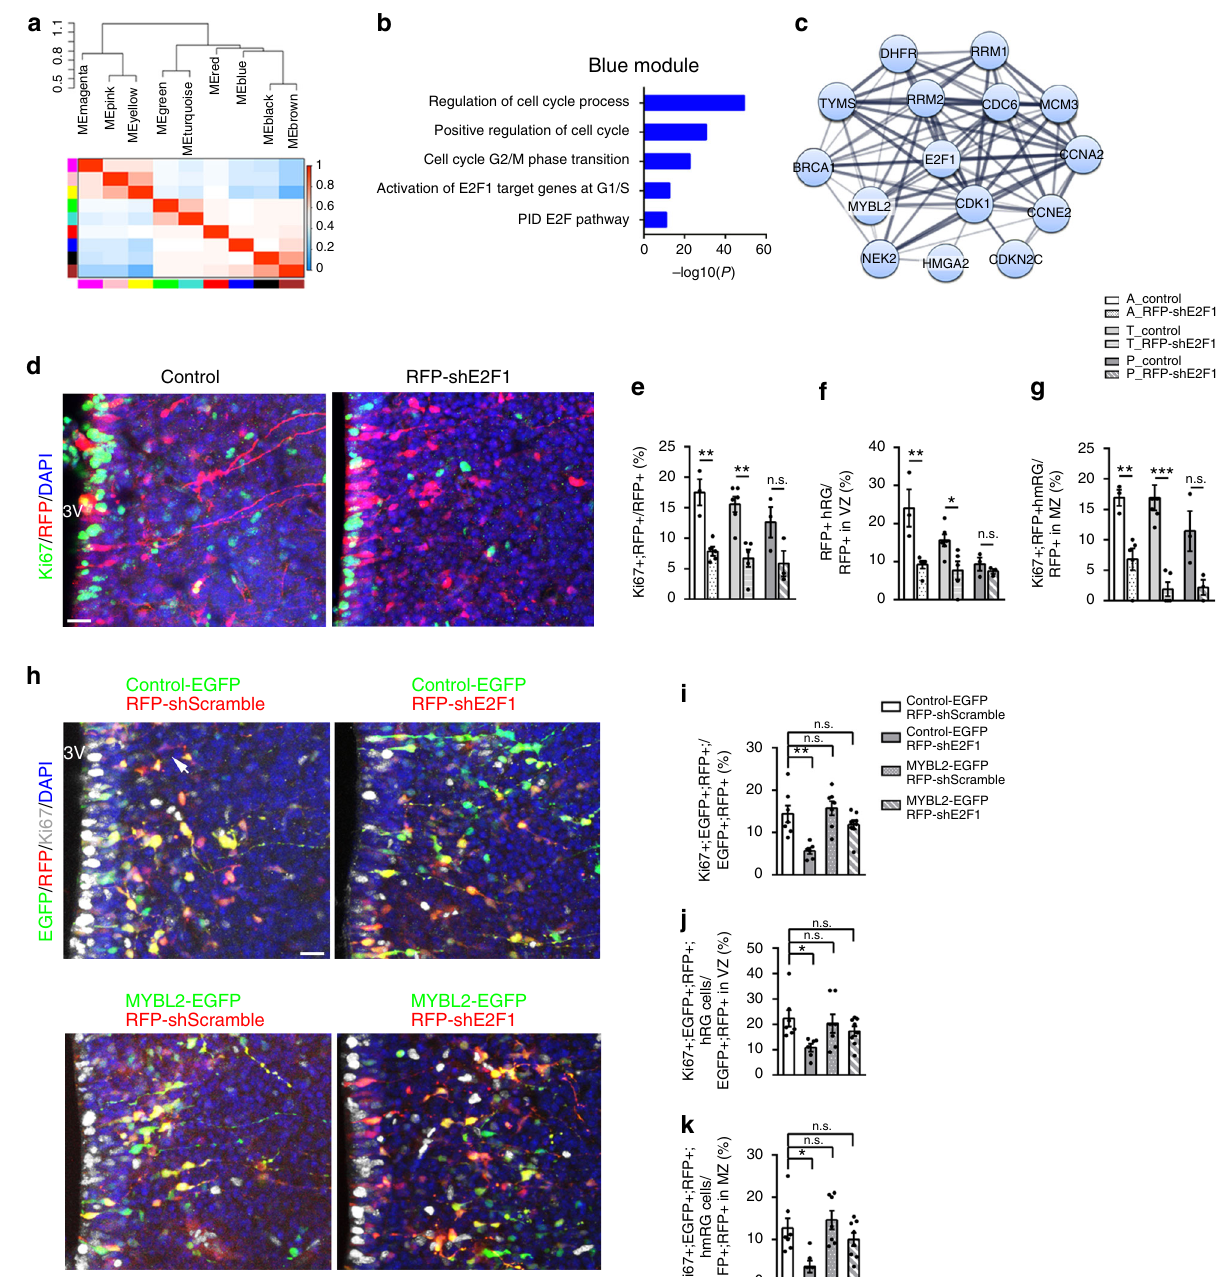
Fig. 5 Molecular signature of neural progenitor cells in the developing hypothalamus. a Eigen gene heatmap showing the relationships among the modules across hypothalamic progenitor population. b Major gene ontology terms or pathways associated with the blue modules. c Functional network of genes/proteins involved in regulation of cell cycle. The network was generated with the STRING tool. d The knockdown of E2F1 decreased proliferating progenitor in mice hypothalamus ( n = 3 independent experiments). Representative images of E14.5 hypothalamic sections electroporated with shControl (red) and shE2F1 (red) plasmids at E12.5 and immunostained with Ki67. Scale bar, 50 μ m. e – g Quanti fi cation for the percentage of Ki67 + cells among RFP + cells ( e ), Ki67 + hRG cells among RFP + cells in hypothalamic VZ ( f ) and Ki67 + hmRG cells among RFP + cells in hypothalamic MZ ( g ), respectively in the anterior – posterior axes. A: anterior, T: tuberal, P: posterior ( n = 3 independent experiments); p A_control vs. A_RFP-shE2F1 = 0.002 ( e ), p T_control vs. T_RFP-shE2F1 = 0.003 ( e ), p P_control vs. P_RFP-shE2F1 = 0.1056 ( e ); p A_control vs. A_RFP-shE2F1 = 0.0084 ( f ), p T_control vs. T_RFP-shE2F1 = 0.0176 ( f ), p P_control vs. P_RFP-shE2F1 = 0.3729 ( f ); p A_control vs. A_RFP-shE2F1 = 0.008 ( g ), p T_control vs. T_RFP-shE2F1 = 0.0002 ( g ), p P_control vs. P_RFP-shE2F1 = 0.0579 ( g ); * p < 0.05, ** p < 0.01, *** p < 0.001, two-tailed Student ’ s t test. h Overexpression of MYBL2 rescues the hypothalamic progenitor decrease by E2F1 knockdown in mice ( n = 3 independent experiments). Co-expression of shE2F1-RFP and MYBL2-EGFP using electroporation at E12.5 mice. Samples of the E14.5 hypothalamus are immunostained by Ki67. Scale bar, 50 μ m. i – k Quanti fi cation for the percentage of Ki67 + cells among electroporated EGFP + RFP + cells. n = 7 brain slices from 3 animals in Control-EGFP + shScramble, 6 brain slices from 3 animals in Control-EGFP + shE2F1, 7 brain slices from 3 animals in MYBL2-EGFP + shScramble, and 8 brain slices from 4 animals in MYBL2-EGFP + shE2F1. One-way ANOVA and Tukey ’ s test to compare data sets. n.s.: not signi fi cant. * p < 0.05, ** p < 0.01. Data are presented as mean values ± SEM. Source data are supplied as a Source Data fi